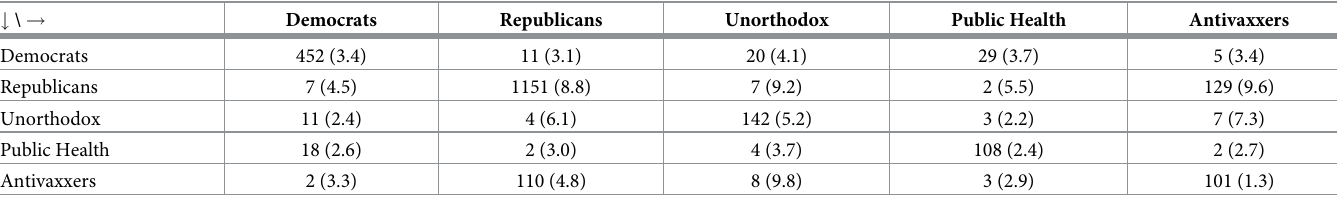
Table notes: Rows ( # ) correspond to the retweeting community, while columns ( ! ) correspond to the retweeted community.